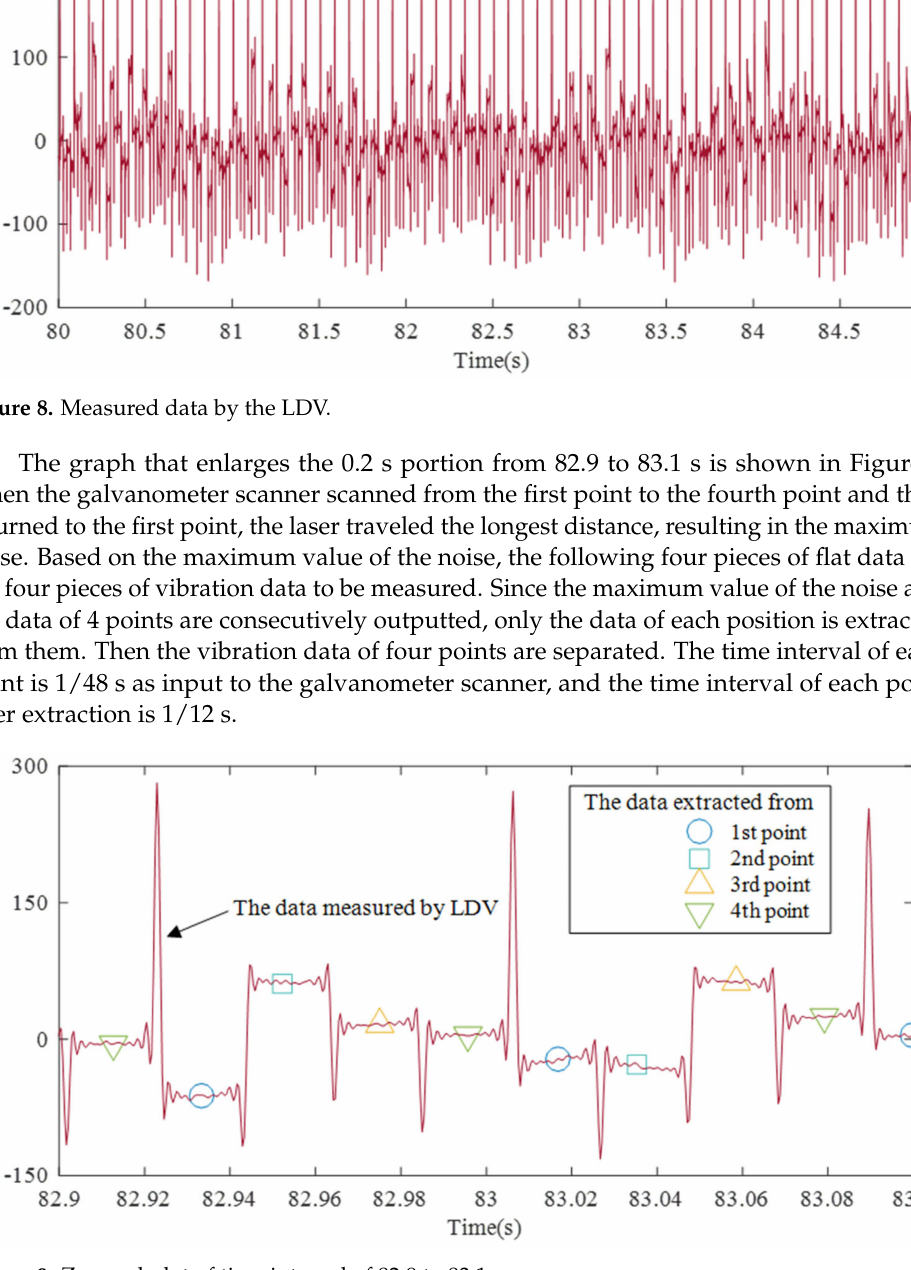
Figure 9. Zoomed plot of time interval of 82.9 to 83.1